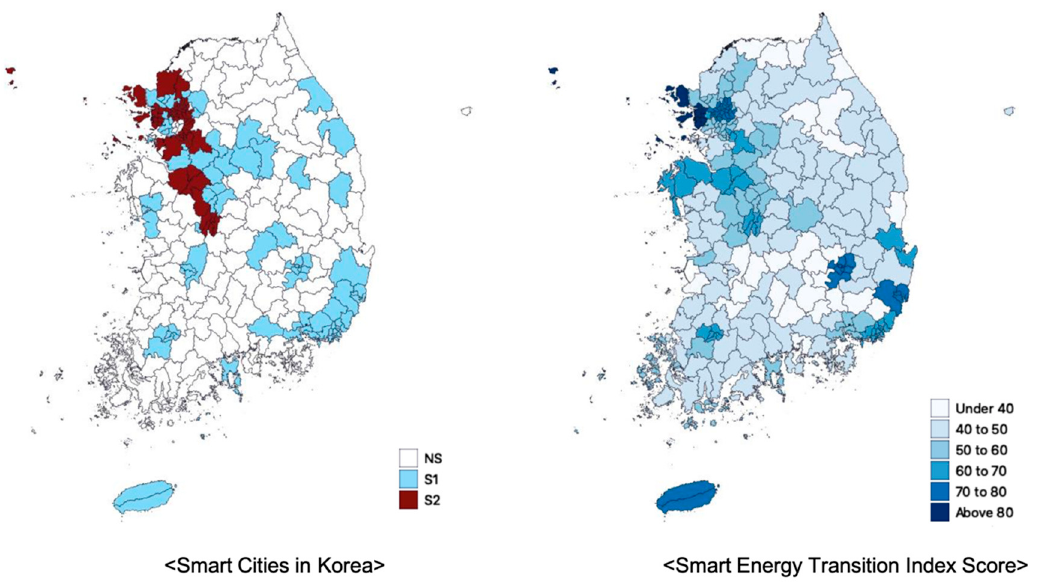
Figure 3. Smart cities and Smart Energy Transition Index in South Korea.